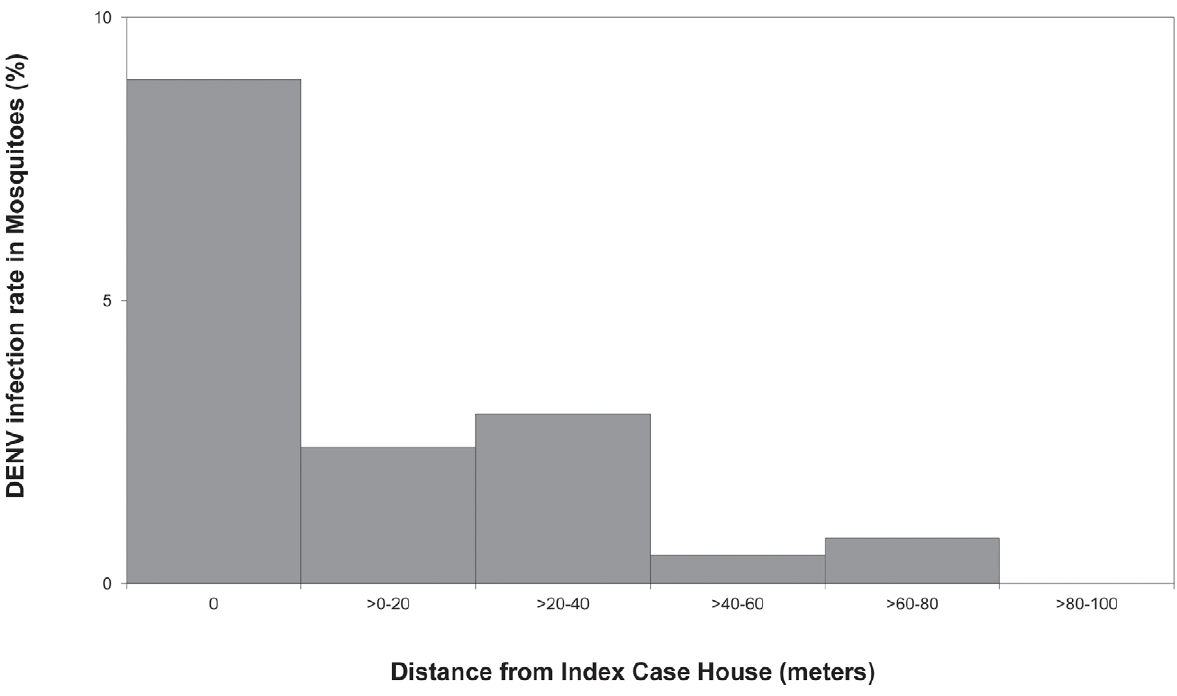
Figure 3. Focal aggregation of DENV-infectious mosquitoes in positive clusters. Relationship between proportion of female Ae. aegypti that were DENV-infectious and distance from index case house was significant (Fisher’s exact, p , 0.001). Distance from index case house 0 m: N=10/ 112; . 0–20 m: N=2/85; . 20–40 m: N=4/138; . 40–60 m: 1/204; . 60–80 m: 2/243; . 80–100 m: 0/206 (N=Infectious mosquitoes/Collected